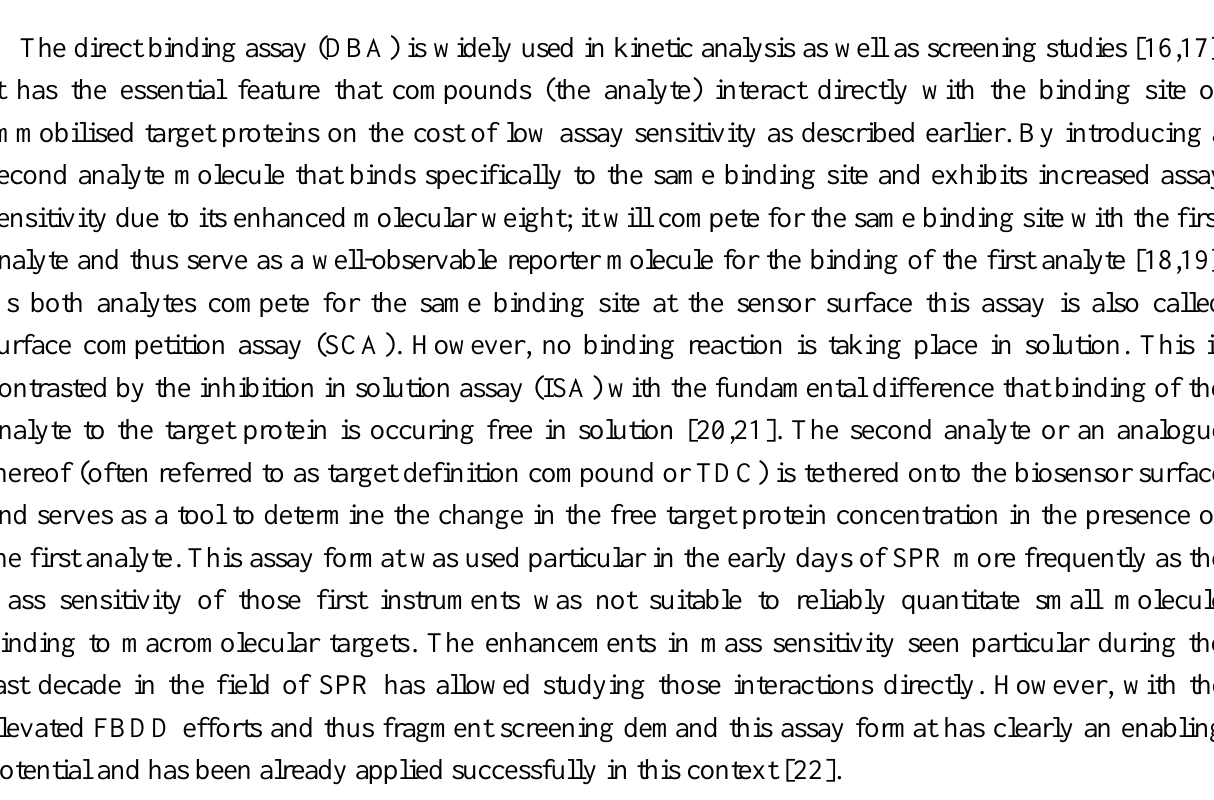
Figure 1. Assay formats. In the direct binding assay the target is immobilized directly